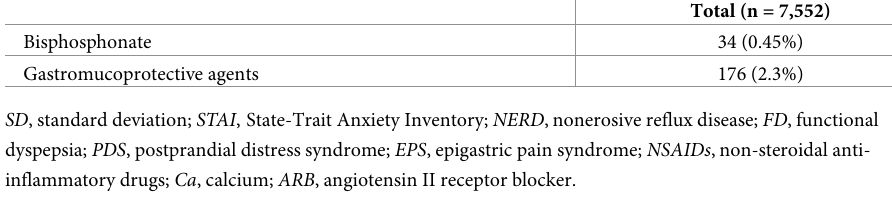
PLOS ONE | https://doi.org/10.1371/journal.pone.0196848 May 3,